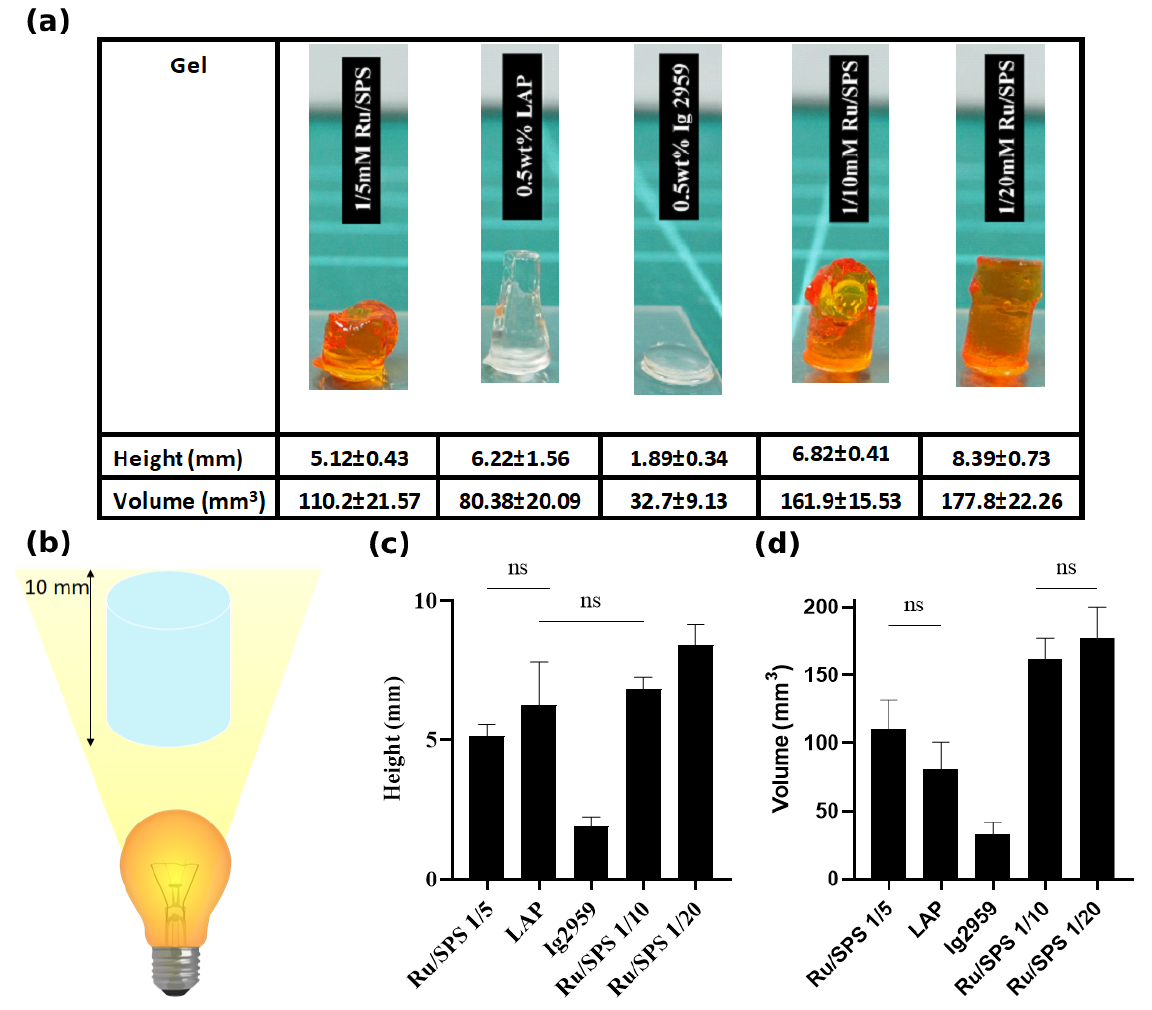
Figure 5. ( a ) Image of GelAGE cast in 10 mm mold with different photoinitiators showing distinct heights and volumes, ( b ) schematic figure showing the direction of light and designed shape of gel, ( c ) depth of cure, and ( d ) curing volume. Values in the figures represent means and standard deviation of N = 6 replicates. ns represents values statistically non-